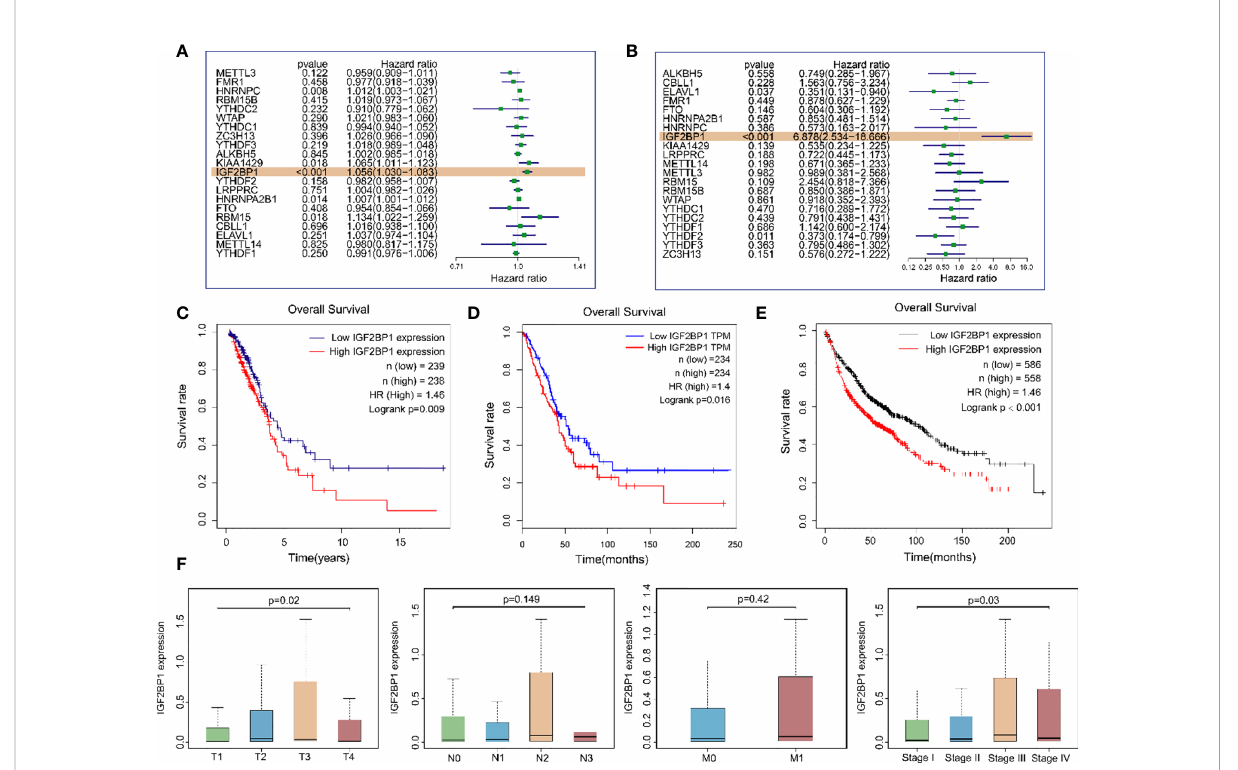
FIGURE 4 The relationship between the expression of IGF2BP1 and the prognosis of LUAD patients. (A) Univariate Cox regression analysis results of m 6 A modulates gene expression levels and samples OS in TCGA-LUAD dataset. (B) Univariate Cox regression analysis results of m 6 A modulates gene expression levels and samples OS in the GEO GSE50081 dataset. (C) Overall survival of LUAD patients based on TCGA-LUAD dataset. (D) GEPIA database was used for comparing the OS of LUAD patients with different IGF2BP1 expressions. TPM: transcripts per million. (E) Kaplan – Meier Plotter database was used for comparing the OS of LUAD patients with different IGF2BP1 expressions. (F) IGF2BP1 expression at different clinical stages of